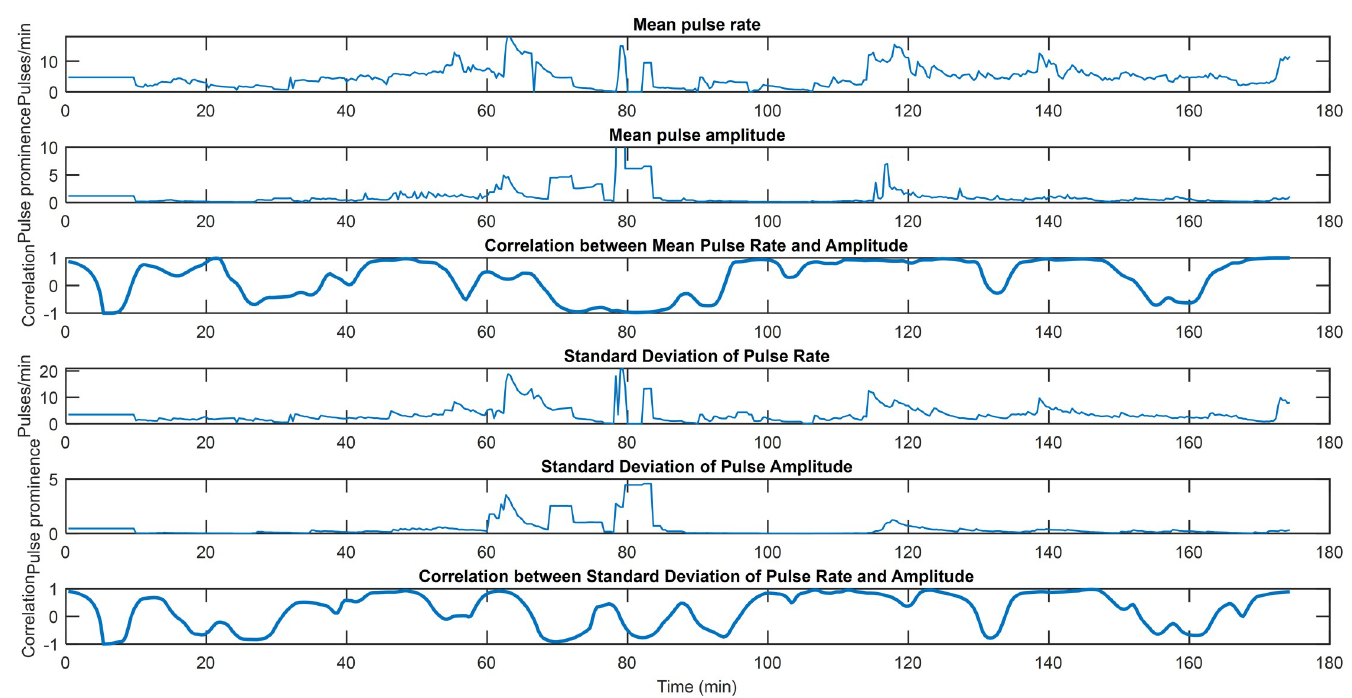
Fig 2. EDA indices from Subject 4. From top to bottom, mean pulse rate, mean pulse amplitude, correlation between mean pulse rate and pulse amplitude, standard deviation of pulse rate, standard deviation of pulse amplitude, and correlation between standard deviations of pulse rate and pulse amplitude. This subject shows several periods of high correlation between rate and amplitude information. However, at approximately 70–90 minutes, pulse rate and amplitude information become strongly anti-correlated. This is because mean and standard deviation of pulse rate remain elevated while mean and standard deviation of pulse rate decrease. This indicates lingering sympathetic tone in the form of sparser but still large